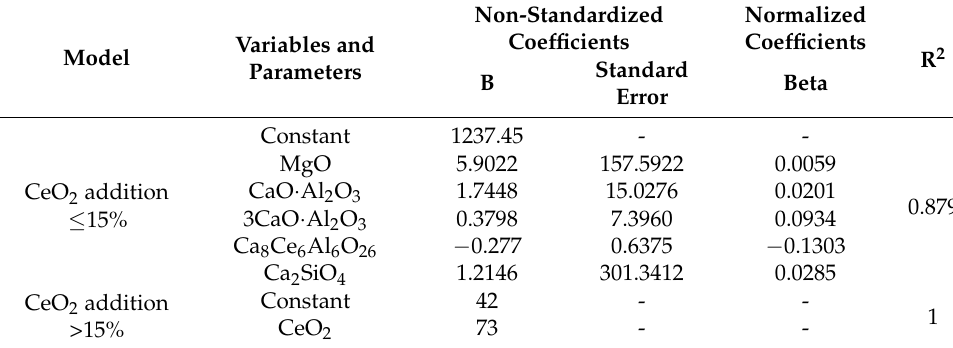
Table 4. Model regression